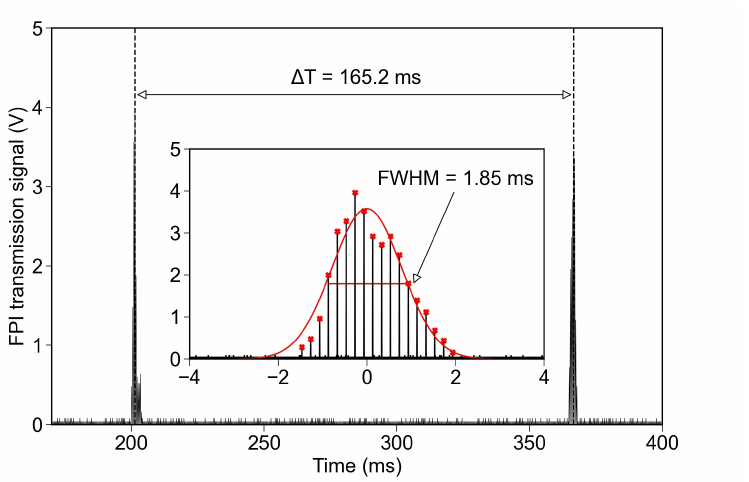
Figure 8. Transmission fringes of the FPI. Due to the pulsed operation a slow scan was performed, so that each transmission peak contained several pulses, allowing a fit of the peak envelope as shown in the